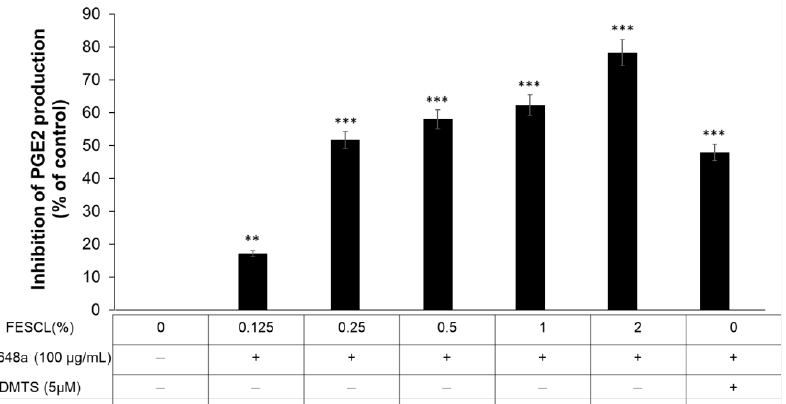
Figure 4 . PGE 2 production inhibition activity of various concentrations of FESCL in Raw cell 264.7 by treatment of PM1648a (100 μ g/mL). There were non-cytotoxic concentrations of FESCL by 2%. All data were reported as the mean ± SD of three replicates. ** p < 0.01 and *** p < 0.001 vs. the PM1648a treated control group. DMTS, dexamethasone. treated control group. DMTS,